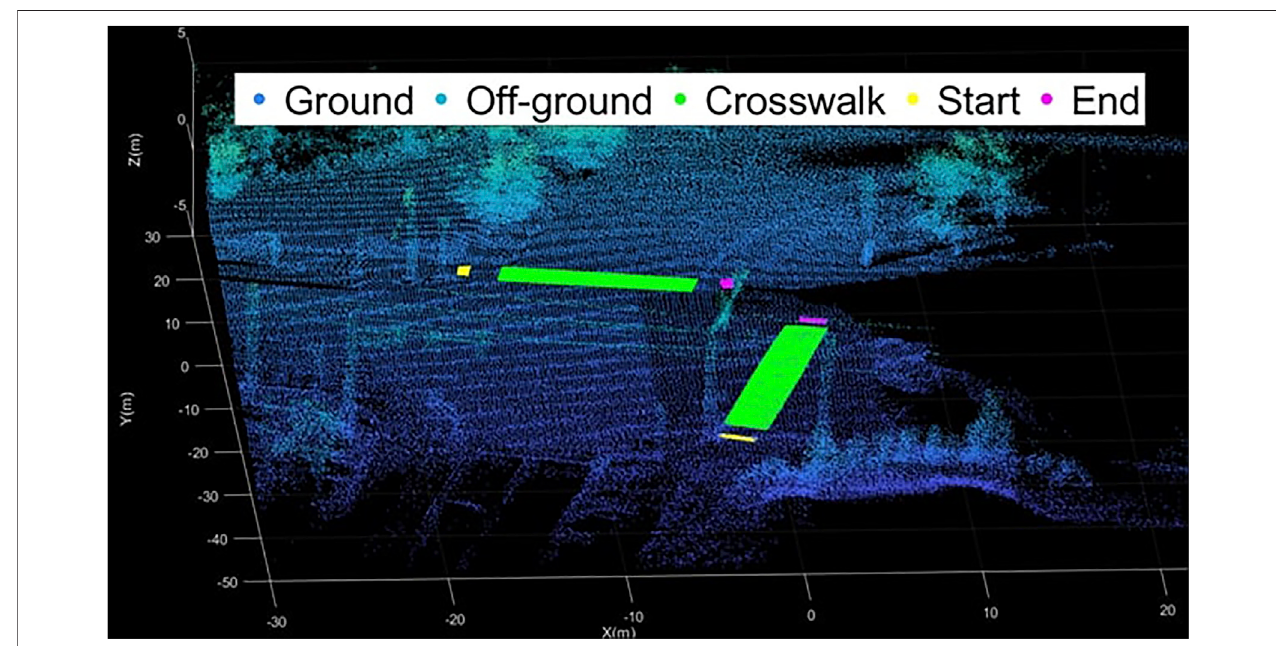
FIGURE 3 | The prior map is annotated with semantic information with matched points. “ Start ” and “ End ” are texture plates which are helpful to visually impaired people providing tactile information. It can be reversed depending on direction of crossing.